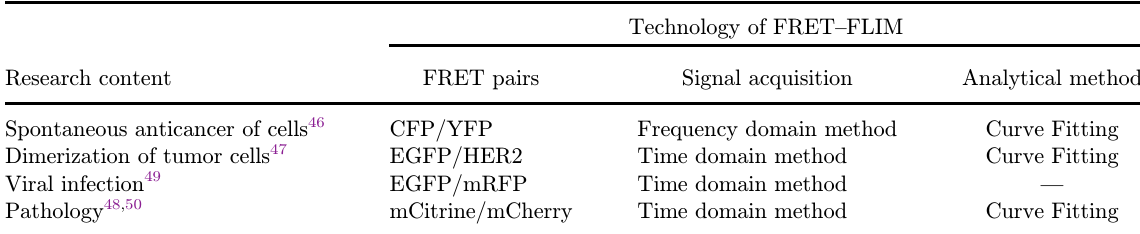
Table 2. Application of FRET – FLIM technique in pathological research. 47 – 50